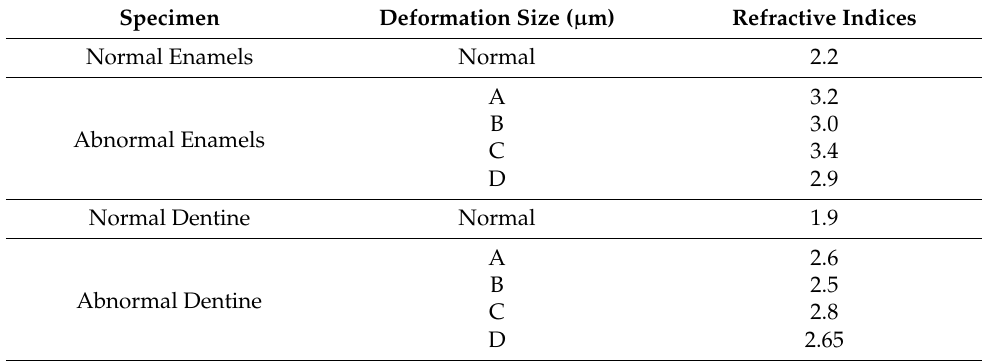
Table 1. Refractive indices of cell with respect to the deformation.